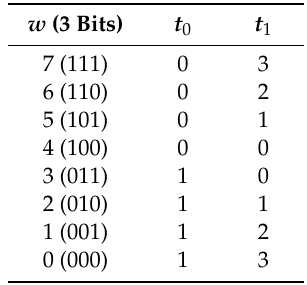
Table 1. Relation between secret data w and ( t 0 , t 1